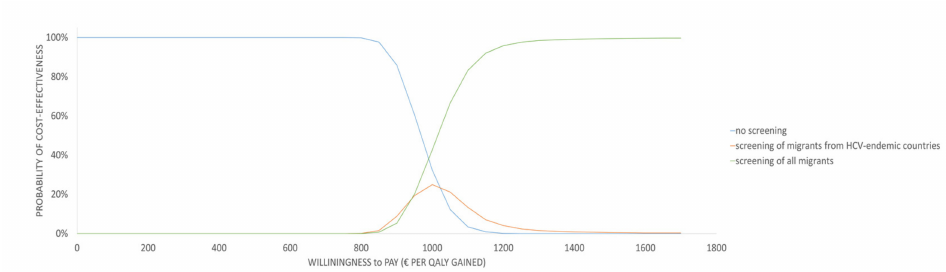
Figure 5. Cost-e ff ectiveness acceptability